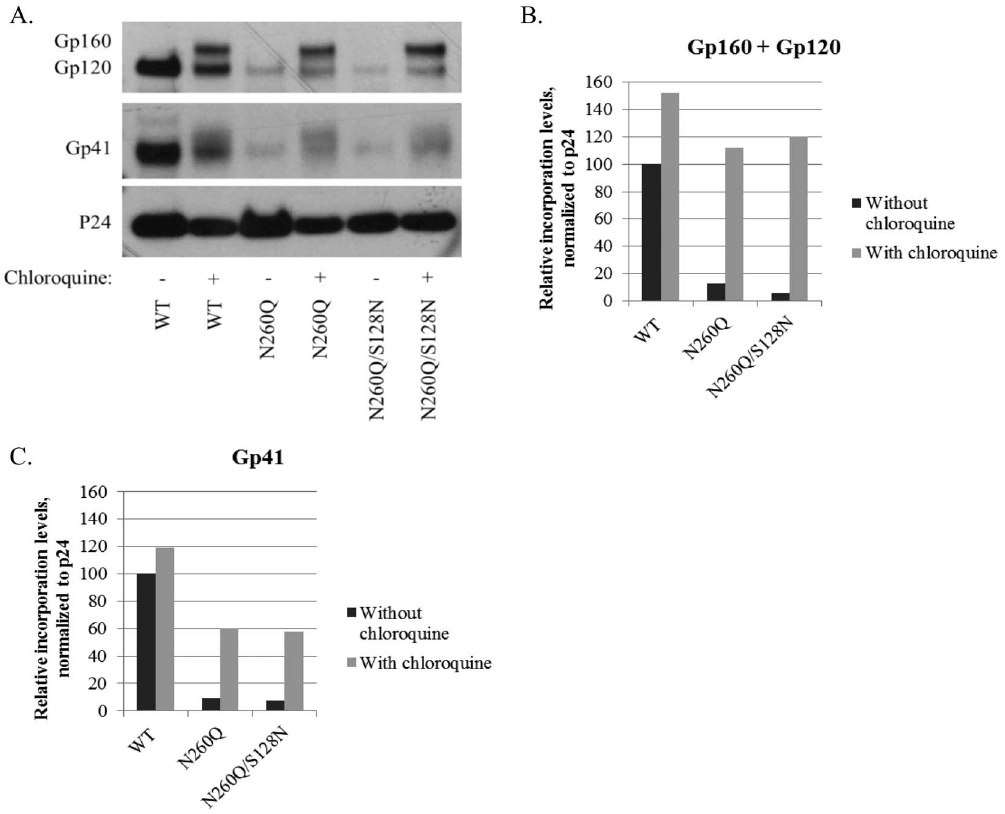
Figure 5. Western blot analysis of the incorporation levels of gp160, gp120 and gp41 in viral particles. (A) Analysis of the level of gp160, gp120 and gp41 incorporation in virus particles, produced in the absence or presence of the lysosomal inhibitor chloroquine. P24 was quantified as an equal loading control. (B–C) Relative protein levels as quantified based on panel A using the ImageJ software, and normalized to equal p24 levels.